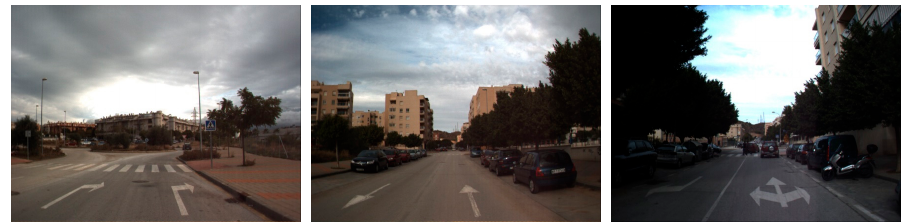
Figure 6. Example images from Málaga urban dataset.